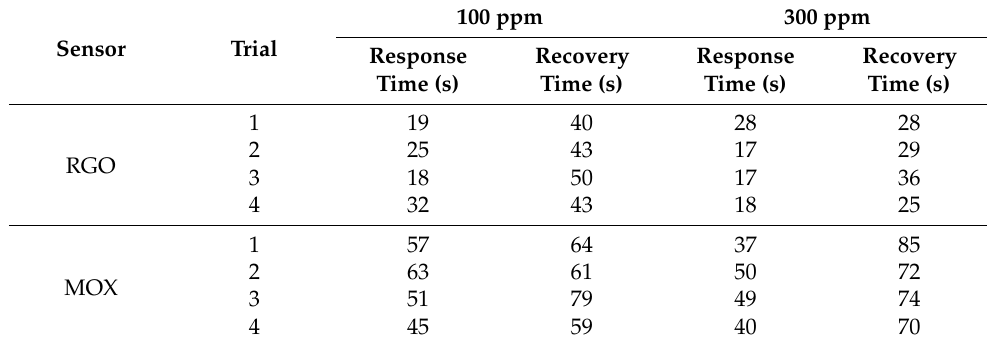
Table 1. Response and recovery time of MOX and RGO to 100 ppm and 300 ppm ethanol.